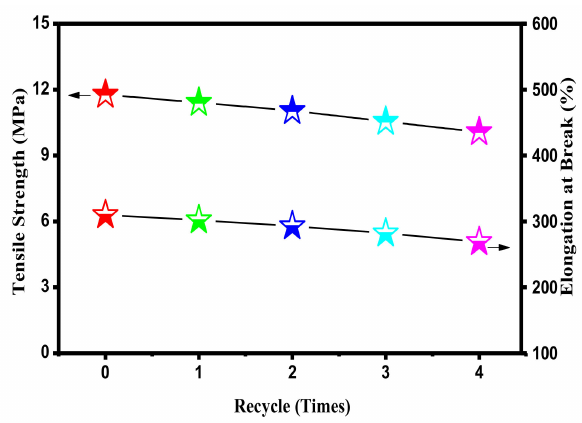
Figure 7. Mechanical properties of repeatability of IIR/PP-TPV with different recycling